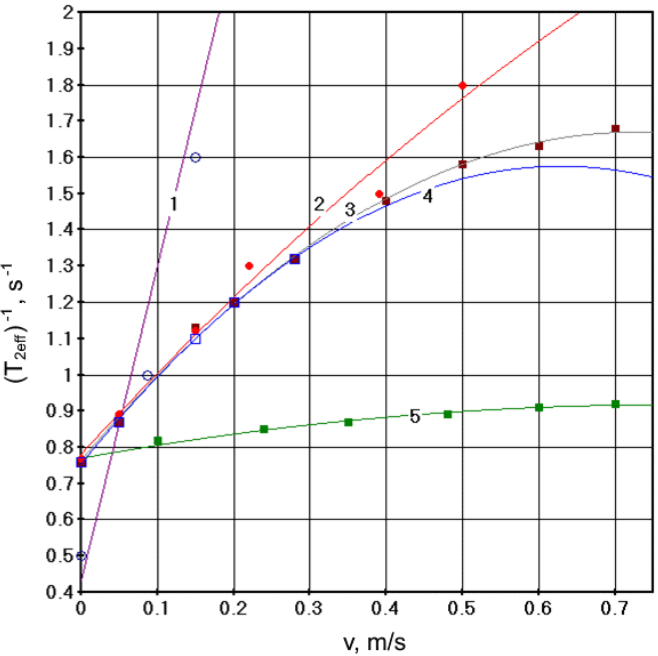
Figure 5. Relaxation rate ( T 2eff ) − 1 from oil-well liquid flow velocity υ for 1 is water, 2 is 90% water emulsion, 3 is 85% water, 4 is 25% water, and 5 is 20% water emulsion flow. For used emulsions, the dependences are two-component, and with correlation coeffi- cients, R 2 = 0.93–0.99 and mean quadratic error S = 0.01–0.08 for υ > 0.2 m/s are